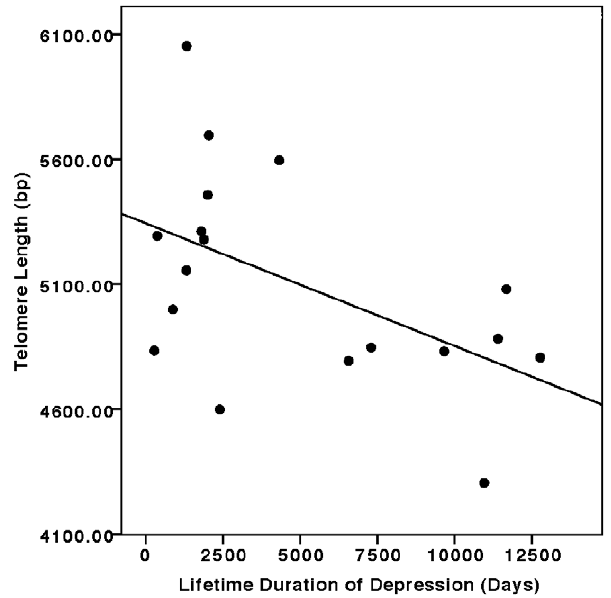
Figure 1. Relationship between cumulative lifetime duration of depression and leukocyte telomere length (in base pairs, bp). (F= 4.70, p , 0.05, controlling for age and sex by hierarchical linear regression).